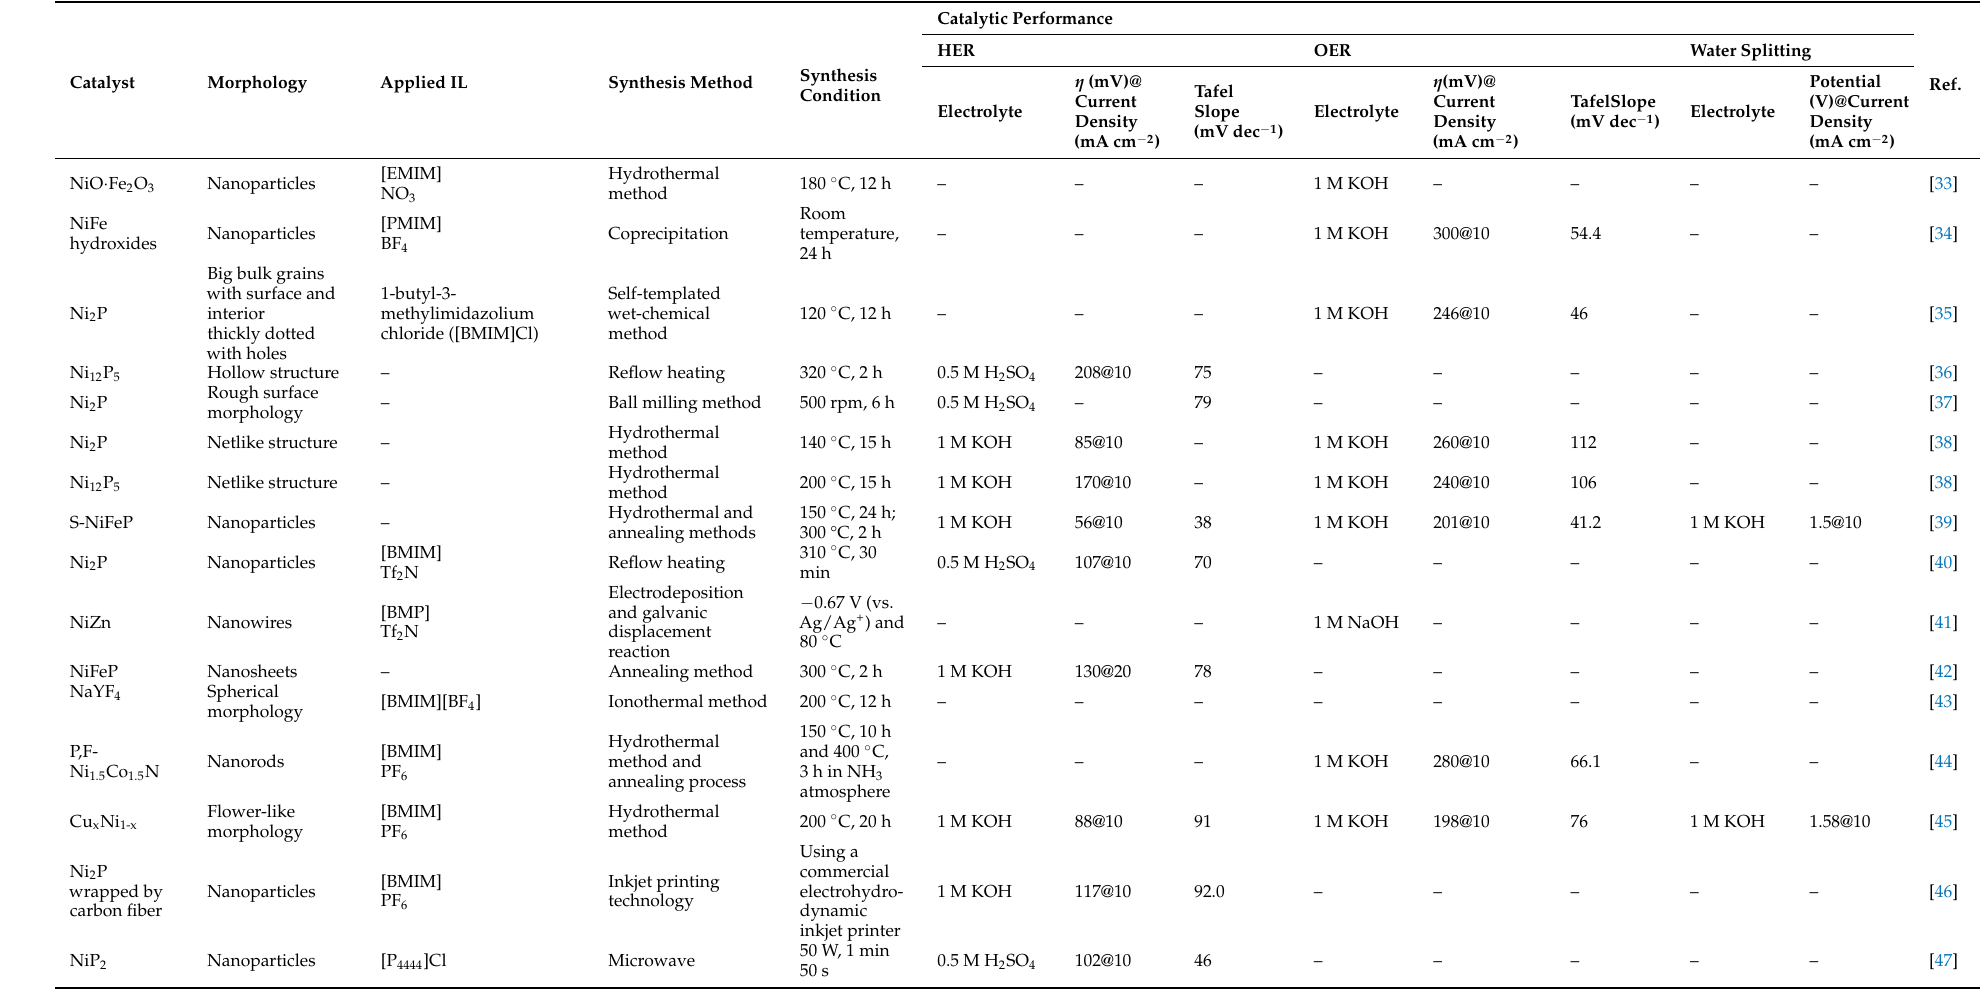
Table 1. Summary of HER, OER and Water Splitting Performance of Catalysts Involved in the Section